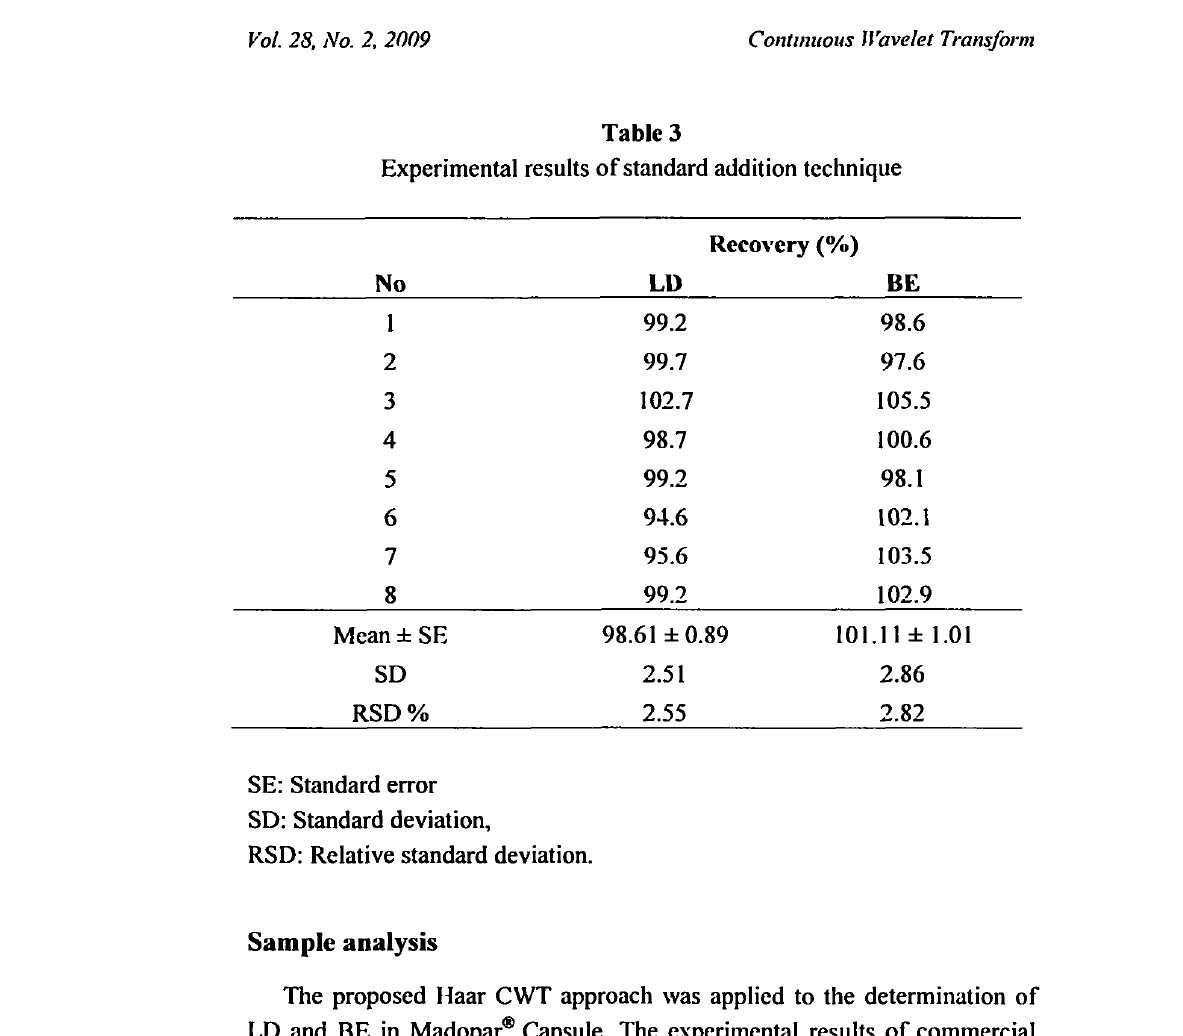
Experimental results of standard addition